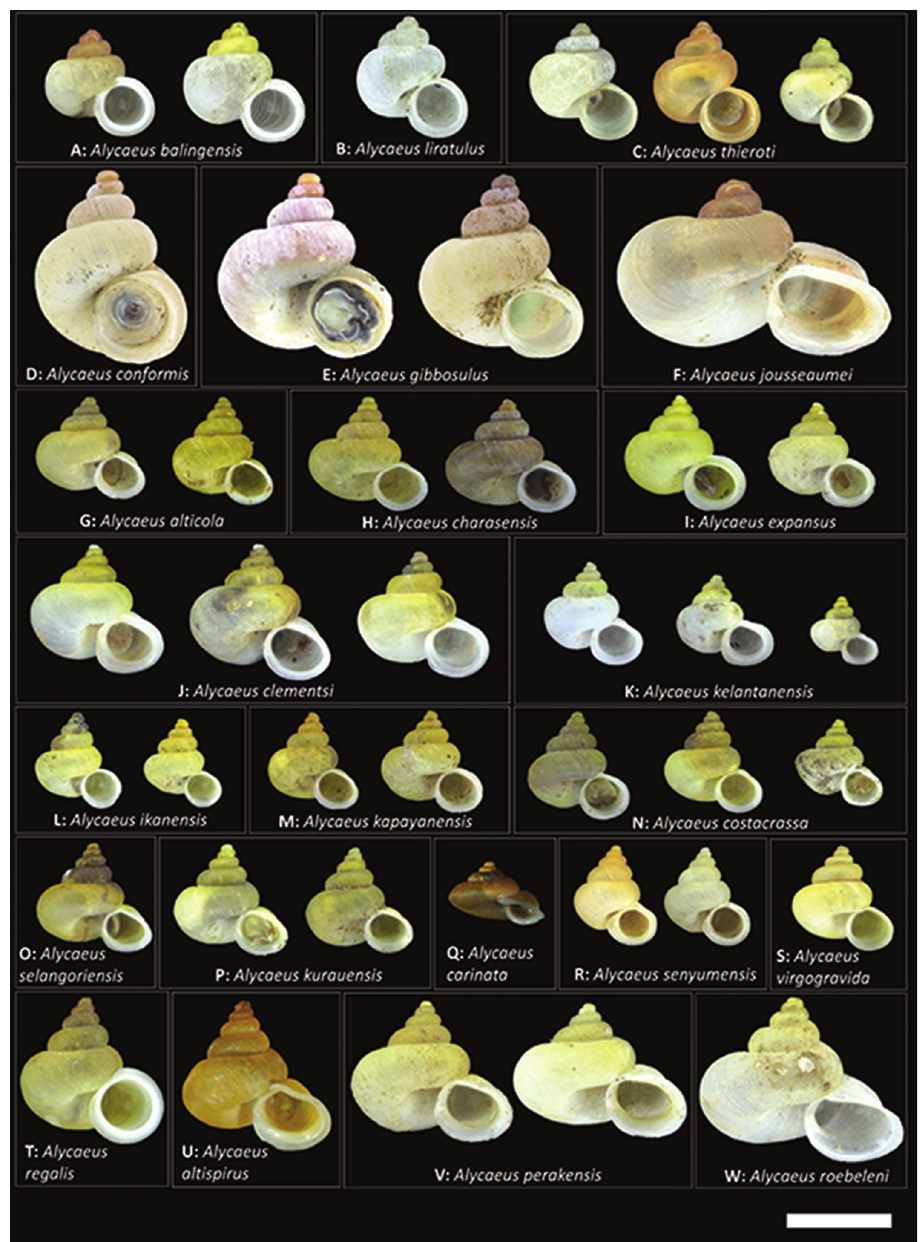
Figure 31. Synoptic view of the 23 Alycaeus taxa in Peninsular Malaysia. Scale bar: 5 mm. Photograph of Alycaeus carinata by Thor Seng Liew. Photograph of Alycaeus altispirus by Páll-Gergely Barna, courtesy of R. Janssen, SMF. All other photographs by Junn Kitt